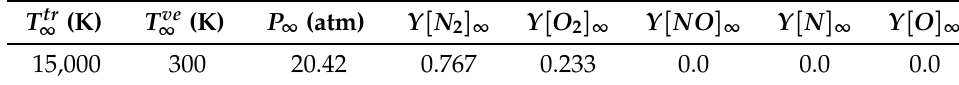
Table 2. Air-5 thermal bath initial conditions.